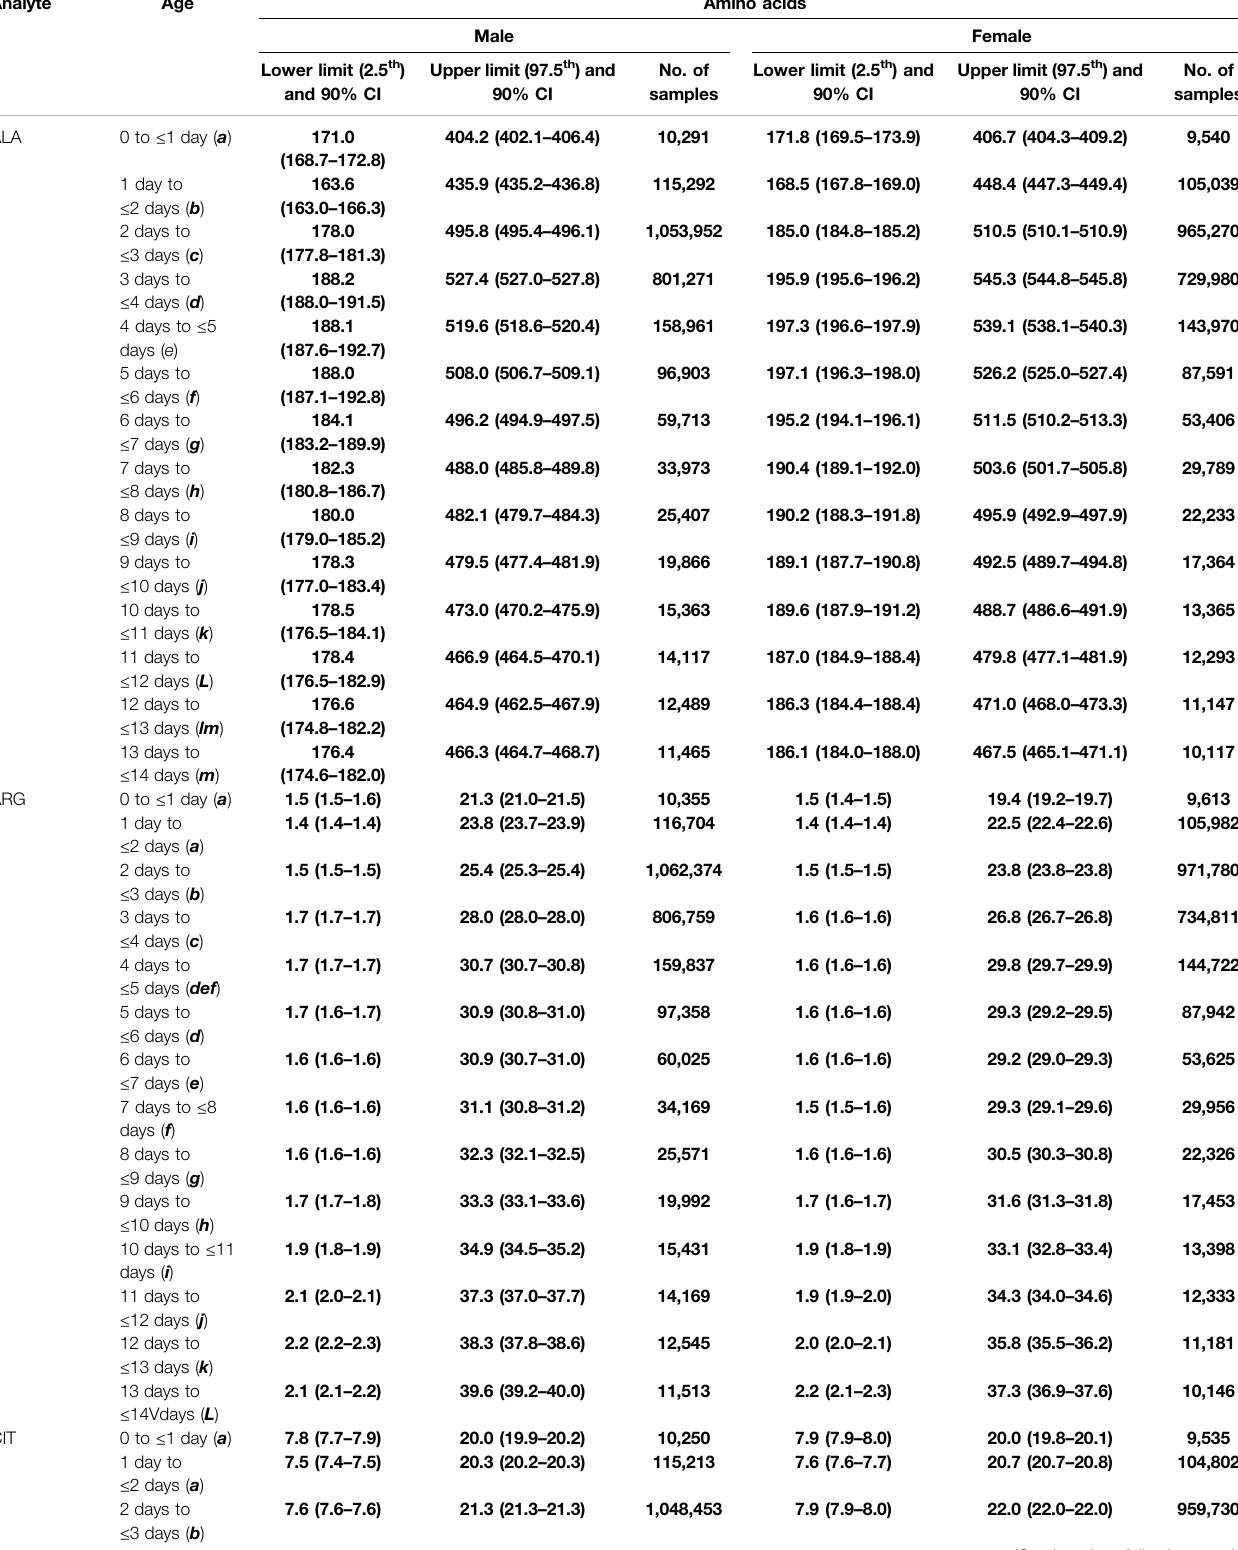
TABLE 2 | The Reference intervals partitioned by each day and sex for 35 MS/MS NBS biomarkers ( μ M). Analyte Age Amino acids